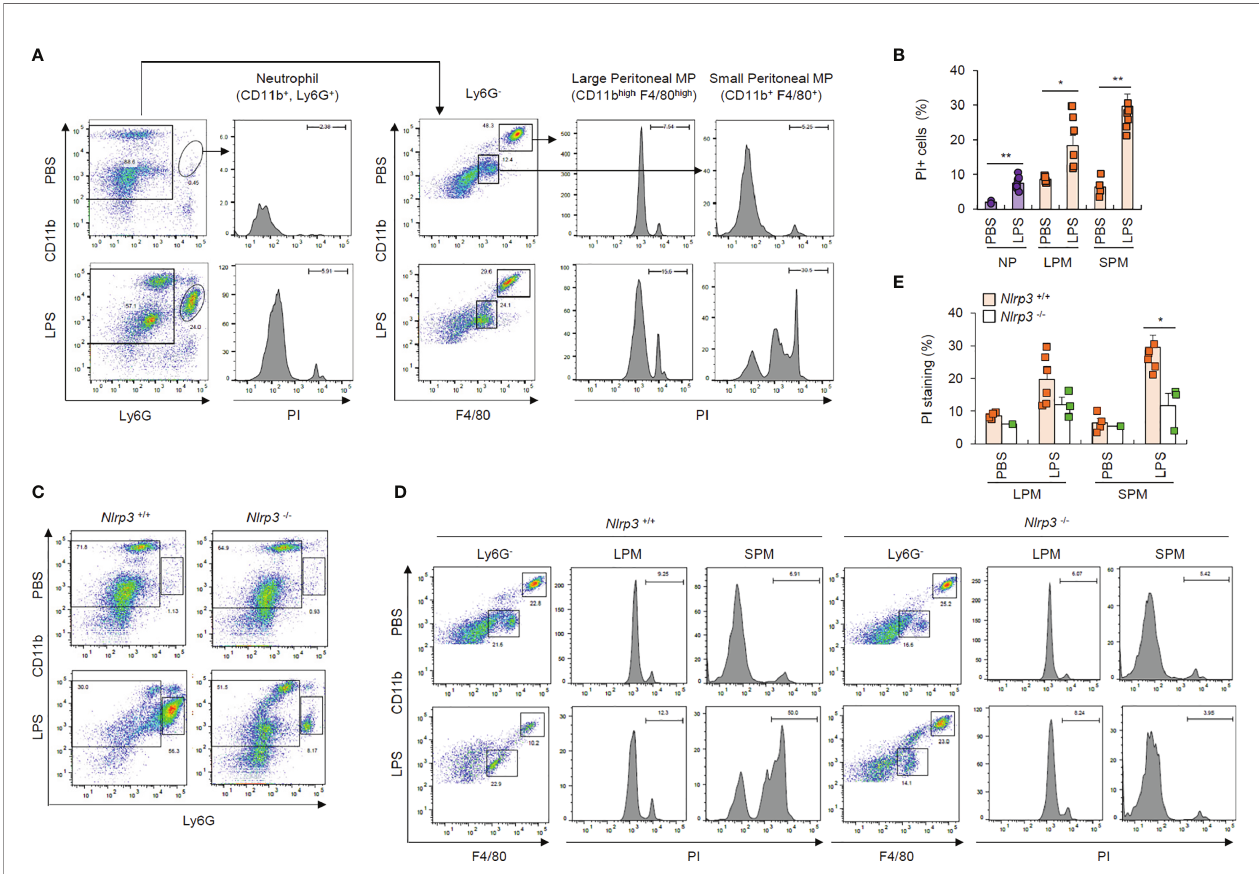
FIGURE 7 | Neutrophils resist pyroptosis in an in vivo mouse model. (A) Flow cytometric analysis of peritoneal lavage from mice administered PBS or LPS (1 mg/kg, 24 h) after staining with anti-CD11b, Ly6G, and F4/80 antibodies and propidium iodide (PI). (B) Quanti fi cation of PI-positive cells of neutrophils (NP), large or small peritoneal macrophages (LPM or SPM) as indicated in (A) ( n = 2~7). (C, D) Flow cytometric analysis of mouse peritoneal lavage from wild-type or Nlrp3 -de fi cient mice administered PBS or LPS (1 mg/kg, 24 h) after staining with anti-CD11b, Ly6G, and F4/80 antibodies and PI. (E) Quanti fi cation of PI-positive cells of LPM or SPM as treated in (D) ( n = 2~7). * P < 0.05, ** P <